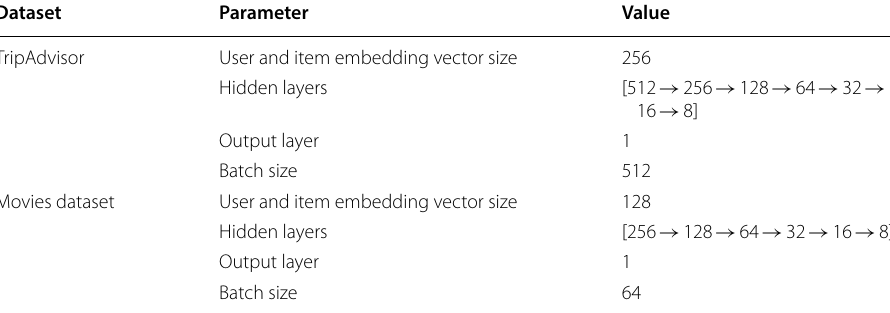
Table 5 Single DNN settings